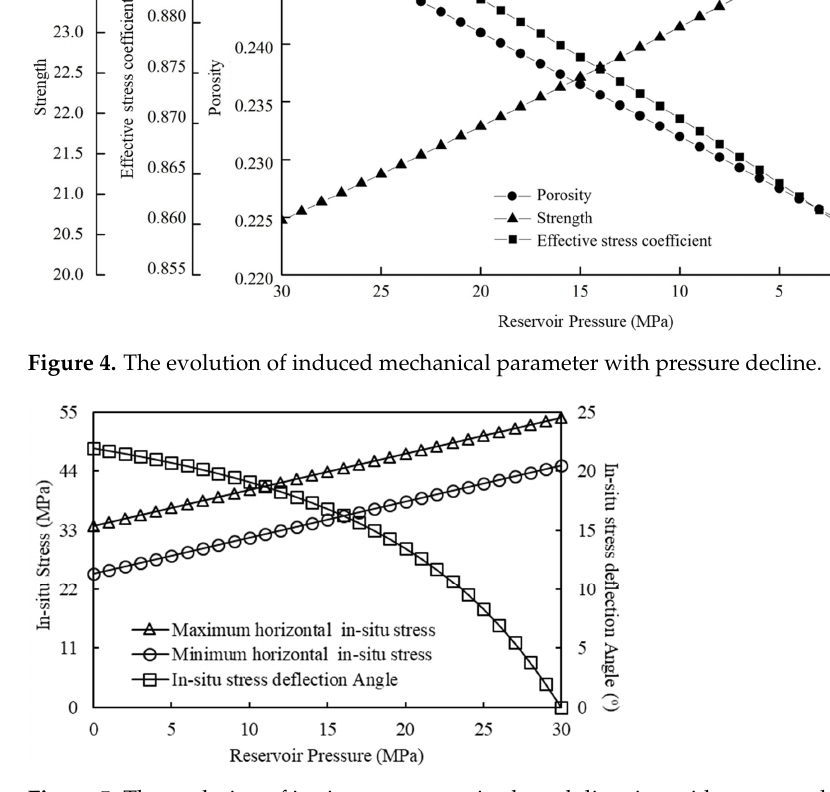
Figure 4. The evolution of induced mechanical parameter with pressure decline. Figure 5. The evolution of in situ stress magnitude and direction with pressure